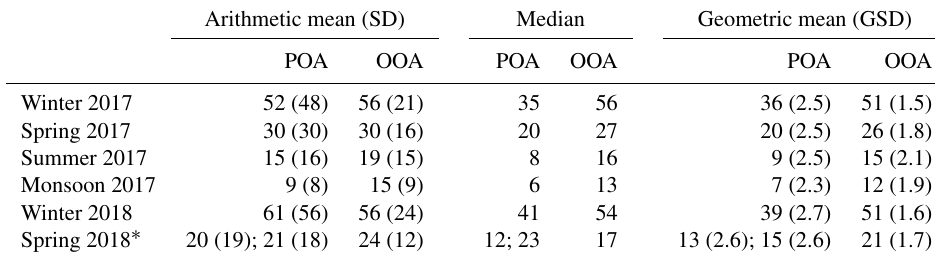
Table 3. Organic-only PMF factor concentrations (µgm − 3 ) split into POA and OOA.